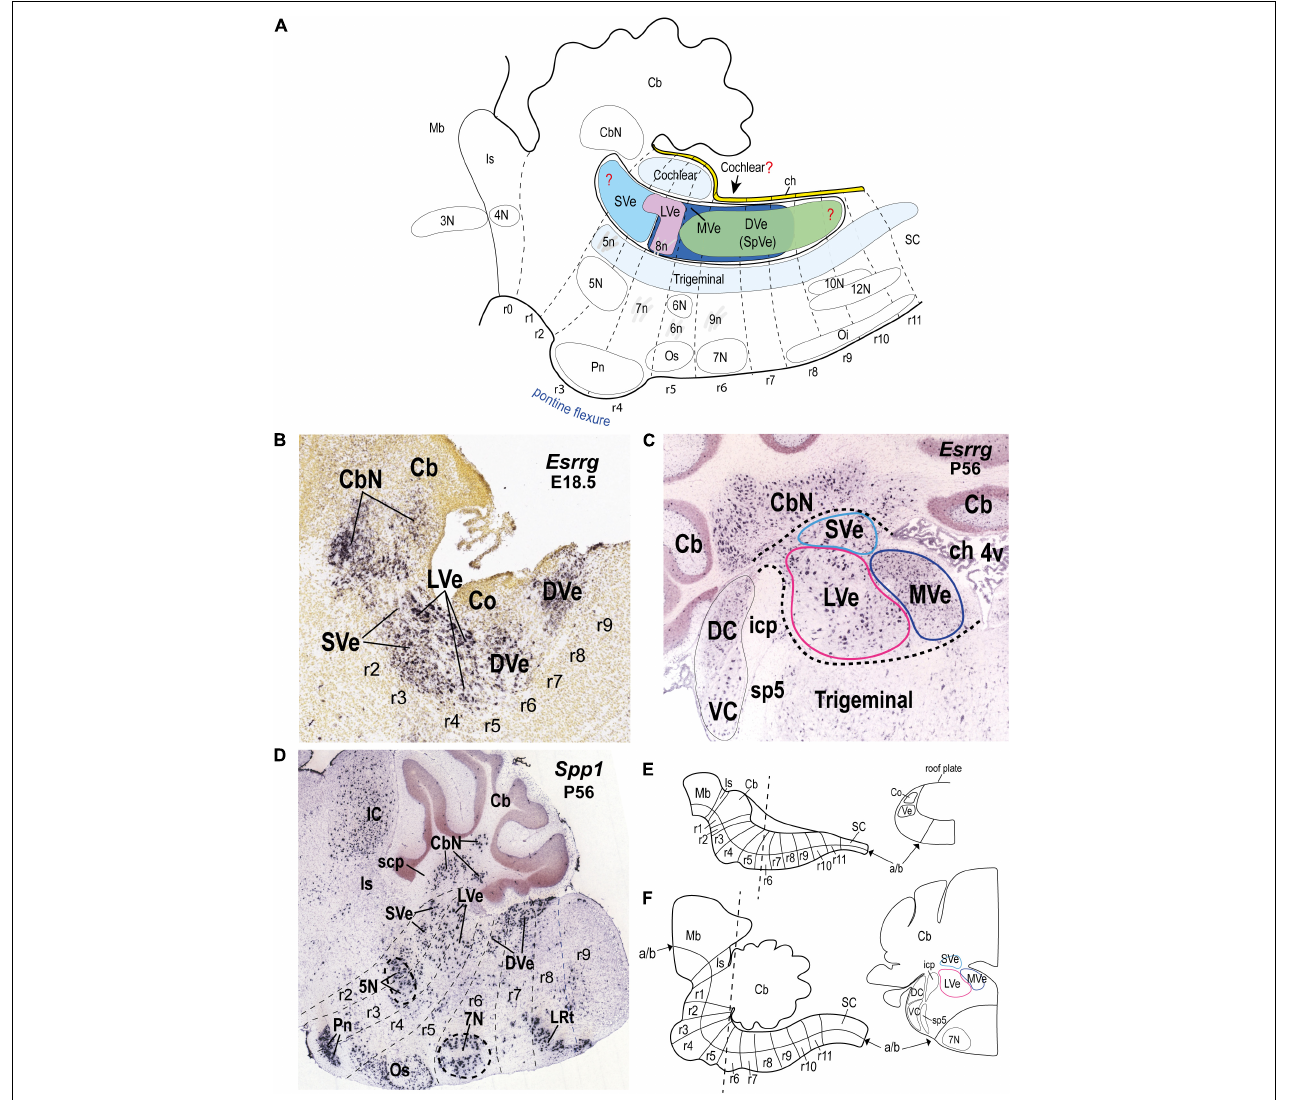
FIGURE 1 | Location of the vestibular column and its main nuclear components in the hindbrain alar plate of the mouse. (A) Schematic sagittal representation of the rostrocaudal extension of the vestibular column in relation to the rhombomeres and neighboring cochlear and trigeminal columns. Anatomical landmarks with known rhombomeric locations are indicated. Red question marks indicate uncertain rostral and caudal limits of the vestibular column and uncertain caudal limit of the cochlear column. The trigeminal column extends up to r2 (Oury et al., 2006). Schema based on Farago et al. (2006); Oury et al. (2006); Pasqualetti et al. (2007); Tomás-Roca et al. (2016); Watson et al. (2017b); Martinez-de-la-Torre et al. (2018); García-Guillén et al. (2021). Rostral is to the left and dorsal is up. (B) Sagittal section of a mouse brain at E18.5 showing Esrrg in situ hybridization signal in identified vestibular nuclei (experiment 100071978; image 9 of 16: Allen Developing Mouse Brain Atlas). (C) Esrrg expression in a coronal section through the vestibular column at P56 (experiment 73616033; image 88 of 109: Allen Developing Mouse Brain Atlas). Medial is to the right. Black dashed lines indicate the contours of the indicated classical vestibular nuclei. Note the presence of Esrrg -expressing cells in the superior, lateral and medial vestibular nuclei (LVe, MVe, and SVe), and cerebellar and cochlear nuclei (CbN, DC, and VC). (D) Expression of Spp1 in the hindbrain at P56 (experiment 513488; image 11 of 20: Allen Developing Mouse Brain Atlas). Rhombomeric boundaries are delineated based on the Reference Atlas of the Allen Developing Mouse Brain Atlas. (E) (Left) Schematic sagittal view of the hindbrain from the isthmic rhombomere to rhombomere 11 at approximately E10.5 [modified from Puelles et al. (2013); their Figure 1C ]. (Right) Schematic transverse section at the r5-r6 level indicated in the left panel [adapted from Di Bonito and Studer (2017); their Figure 5B ]. (F) (Left) Schematic sagittal view of the hindbrain from the isthmic rhombomere (r0) to r11 at a postnatal stage [modified from Puelles et al. (2013); their Figure 1E ]. (Right) Schematic transverse section at the r5-r6 level indicated in the left panel [modified from the mouse brain atlas of Paxinos and Franklin (2013); their Figure 80]; a similar level is photographed in panel (C) . 3N, oculomotor nucleus; 4N, trochlear nucleus; 4v, fourth ventricle; 5N, motor trigeminal nucleus; 5n, motor trigeminal nerve; 6N, abducens nucleus; 6n, abducens nucleus; 7N, facial nucleus; 7n, facial nerve; 8n, vestibulo-cochlear nerve; 9n, glossopharyngeal nerve; 10N, dorsal vagal motor nucleus; 12N, hypoglossal motor nucleus; a/b, alar/basal boundary; Cb, cerebellum; CbN, cerebellar nuclei; ch, choroid tela; Co, cochlear column; DC, dorsal cochlear nucleus; DVe (SpVe), descending (spinal) vestibular nucleus; IC, inferior colliculus; icp, inferior cerebellar peduncle; Is, isthmus; LRt, lateral reticular nucleus; LVe, lateral vestibular nucleus; Mb, midbrain; MVe, medial vestibular nucleus; Oi, inferior olive; Os, superior olive; Pn, pontine nuclei; r, rhombomere; SC, spinal cord; scp, superior cerebellar peduncle; sp5, spinal trigeminal tract; SVe, superior vestibular nucleus; VC, ventral cochlear nucleus; Ve, vestibular